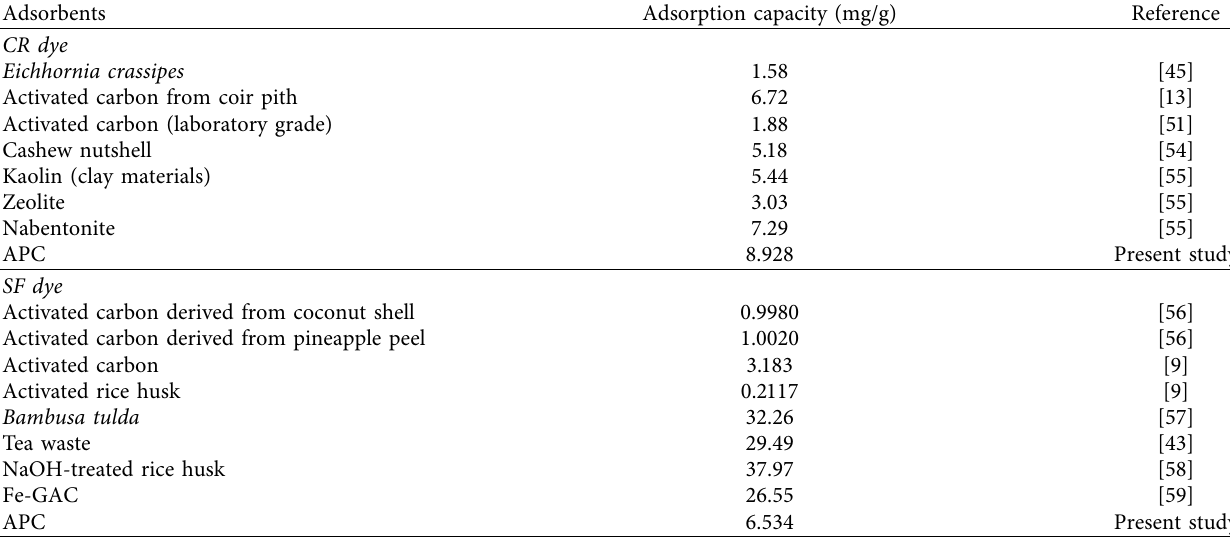
Table 4: Adsorption capacities of various adsorbents onto SF and CR